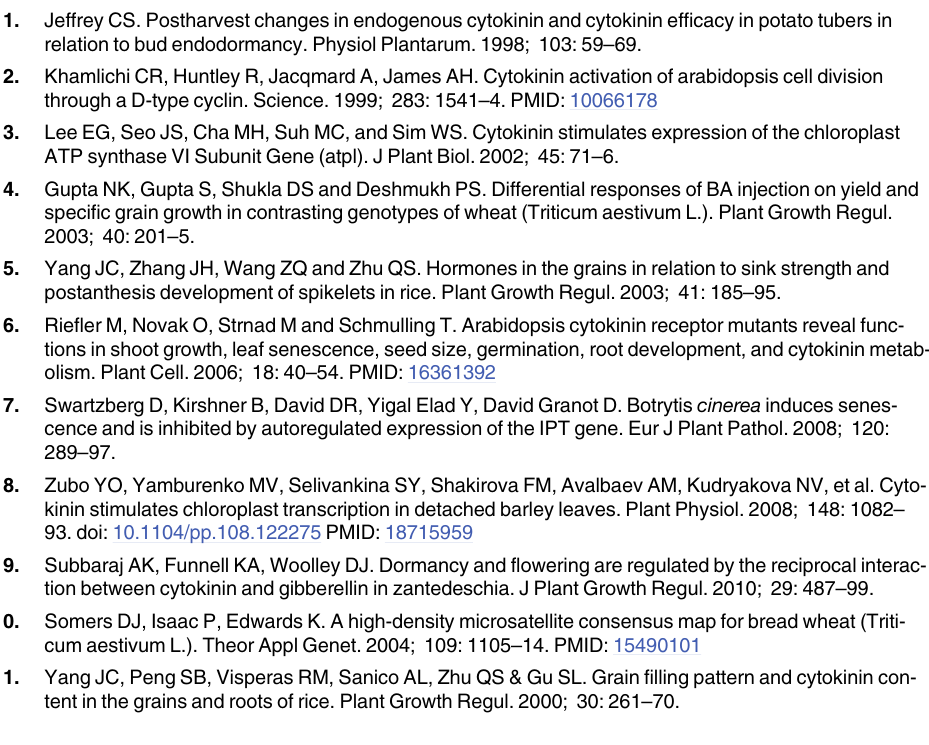
S2 Table. Correlation between the grain traits of RILs. (DOC) S3 Table. The information of grain weight, allele of TaCKX6a02 and distributed region of 102 wheat varieties. (DOCX) S1 Fig. Amplification of the TaCKX6a02 gene using the primer pair T31 – 32 in Chinese Spring nulli – tetrasomics. (TIF) S2 Fig. Grains of 12 wheat varieties with large difference in grain size and weight. (TIF) S3 Fig. Homology analysis of TaCKX genes.